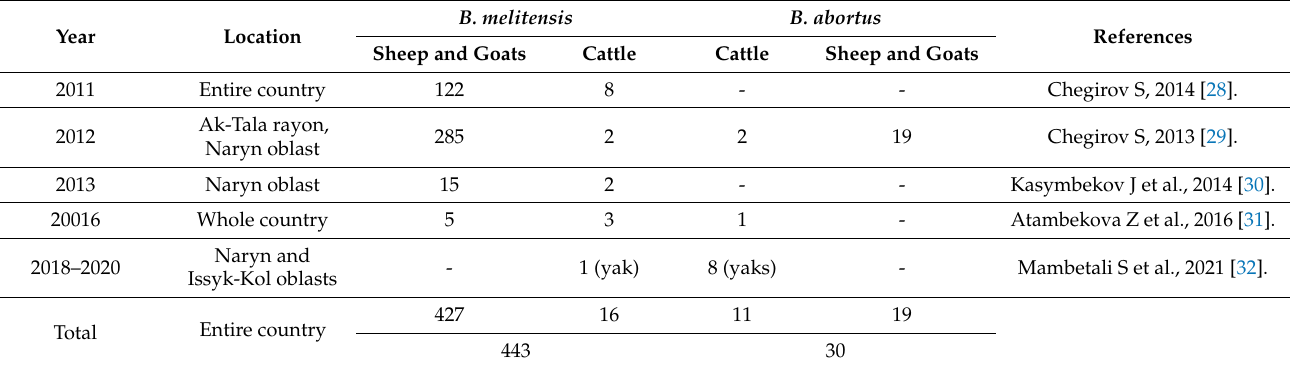
Table 6. Isolation sources of Brucella isolates in Kyrgyzstan. Adapted from